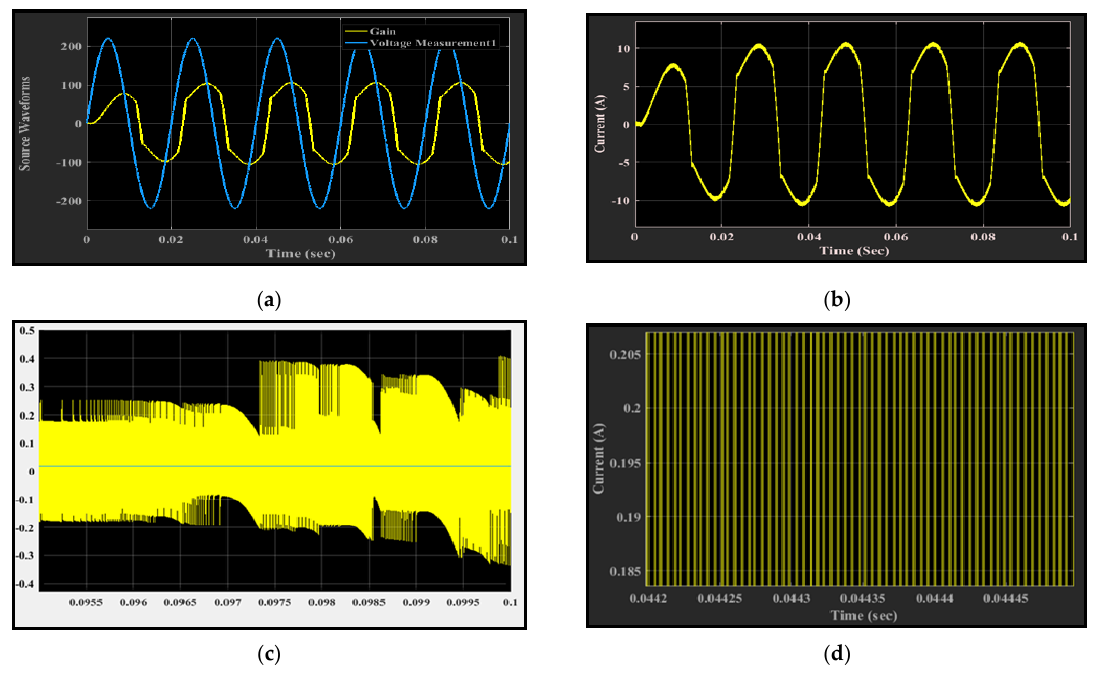
Figure 12. Simulation results of single-phase SAPF by MATLAB/ Simulink environment ( a ) source voltage waveform; ( b ) load current; ( c ) actual output current from SAPF (I o ); ( d ) gate signal (output of hysteresis controller).